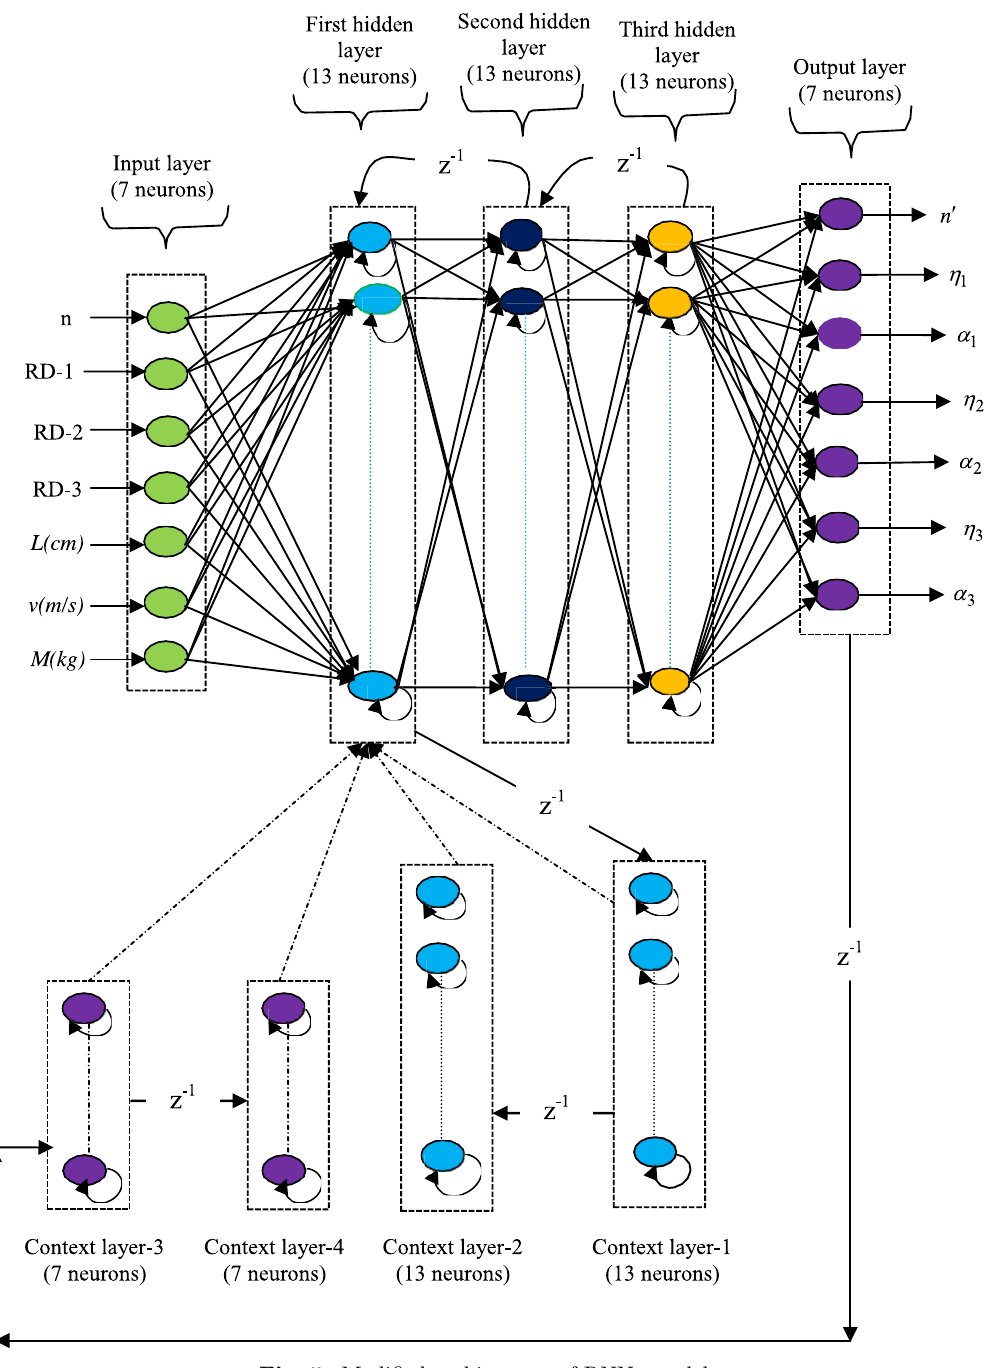
Fig. 5. Modi fi ed architecture of RNNs